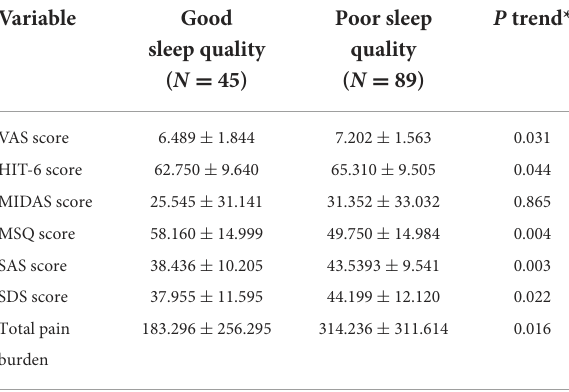
TABLE 5 Multivariate linear regression analysis of the effects of poor sleep quality on migraine-related indicators.